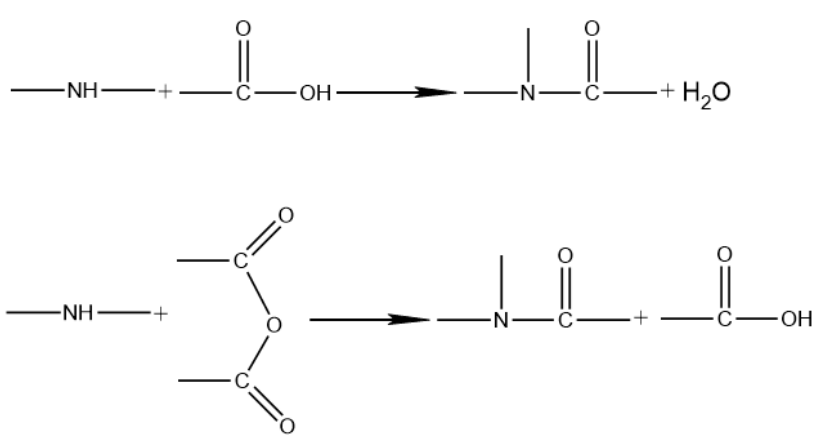
Figure 4. The reaction between activated rubber and asphalt.